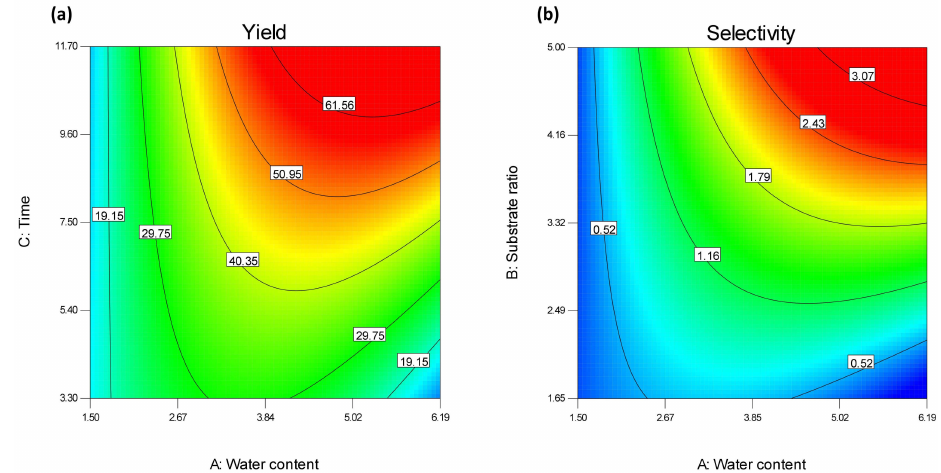
Figure 7. Contour plots for the yield ( a ) and selectivity ( b ) of arabinose ferulate synthesis from FAE125 in hexane. ( a ) Interaction between water content and time, ( b ) interaction between water content and substrate ratio. All other factors were set to their optimum values.